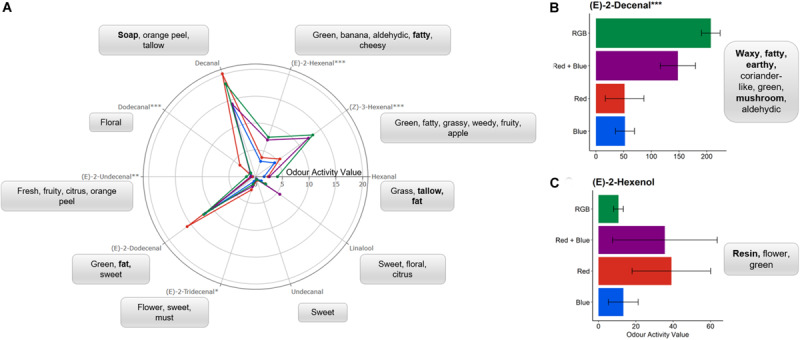
(A) An aroma wheel depicting the odour activity values (OAVs) of 10 of the 12 aromatic compounds identified in C. sativum grown under blue (), red (), RB (), or RGB () spectrums (see Figure 1 and section “Materials and Methods” for details of wavelengths). One-way ANOVAs were performed for each compound and the corresponding P-value with significance between growth spectra treatments indicated by asterisks (***P < 0.0001, **P < 0.001, *P < 0.05, n = 4). Each compound is associated with the generally accepted descriptors; with unpleasant scents highlighted in bold. For clarity, the mean OAVs of (B) (E)-2-decenal and (C) (E)-2-hexenol are plotted separately with standard deviation. Bar charts of the mean OAV and standard deviation for each compound are shown in Supplementary Figure S3.